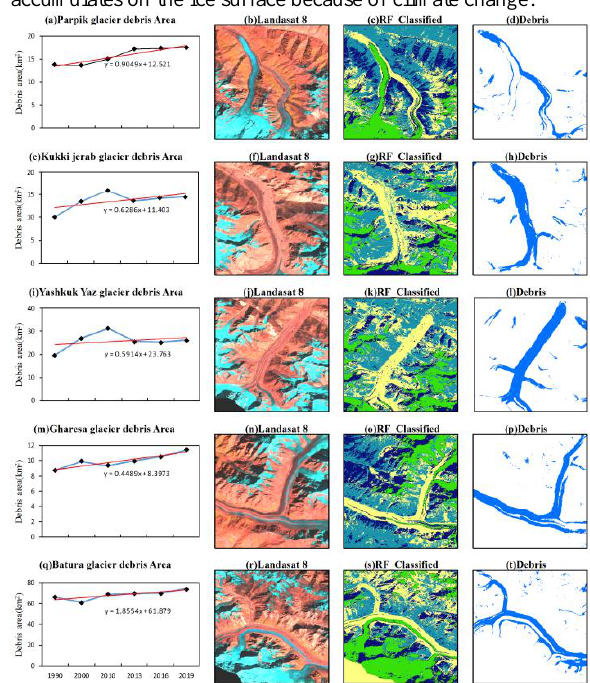
Figure 5. Random forest classifier-based area estimates for five glaciers. Column 1 is estimated debris area in different years and the trend over time, followed by an example of supraglacial debris extraction for each glacier, including the Landsat 8 satellite image in 2009 (Column 2), RF classified results (Column 3), and debris area (Column 4).